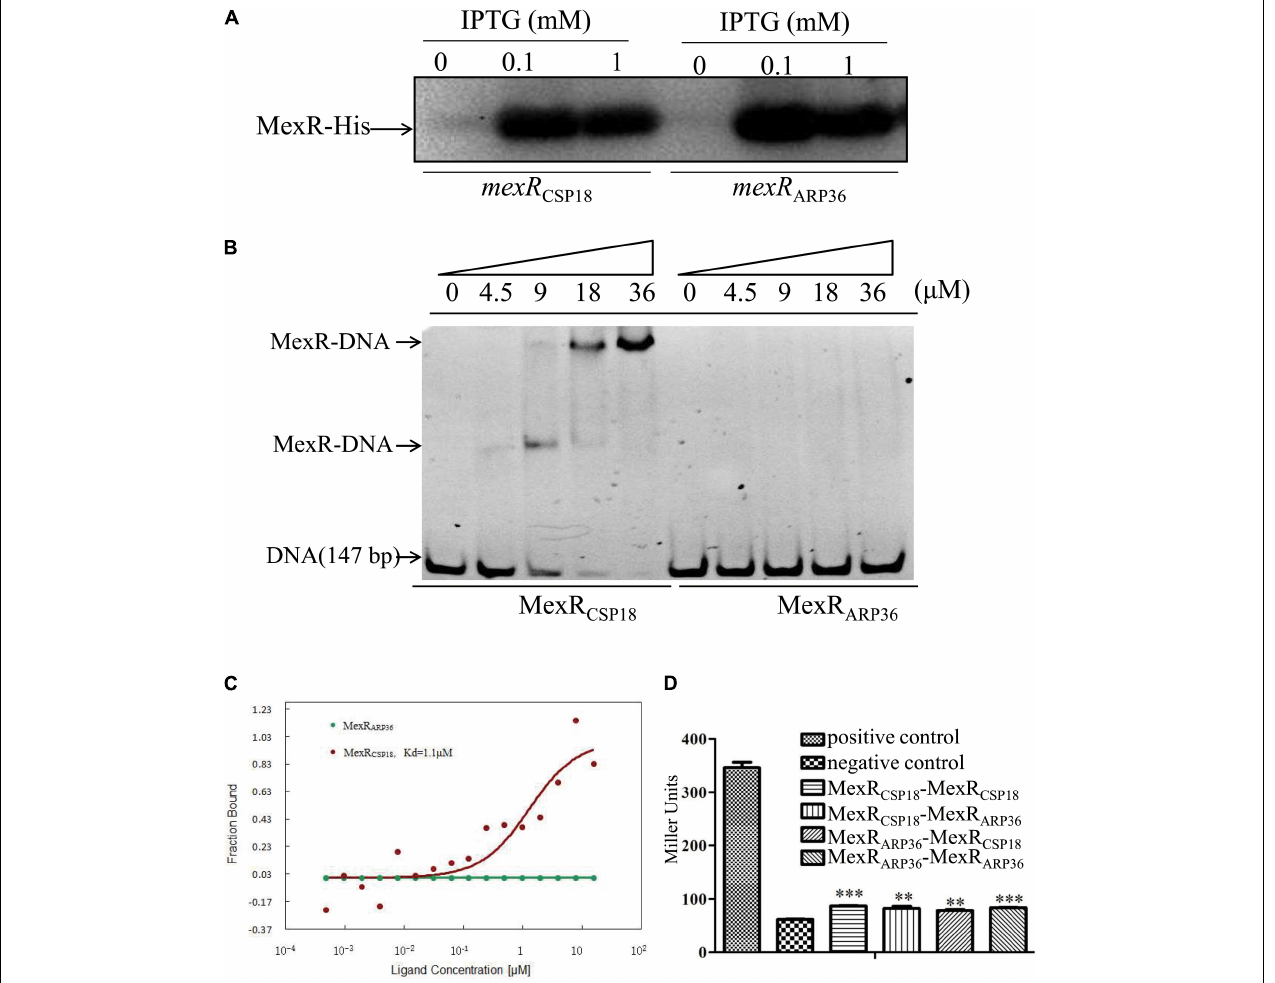
FIGURE 3 | Binding of MexR CSP18 or MexR ARP36 to the intergenic region of mexR - mexAB-oprM and interaction between MexR CSP18 and MexR ARP36 . (A) MexR-His protein detected by Western blot. (B) Binding of MexR to its target DNA was determined by EMSA. Increasing amount of the purified MexR CSP18 -His or MexR ARP36 -His protein was incubated with intergenic region of mexR - mexA . The mixtures were electrophoresed on a native PAGE gel, and the bands were visualized under UV light following ethidium bromide staining. Data represent results from three independent experiments. (C) MST assay to test the binding capability of MexR ARP36 or MexR CSP18 to the intergenic region of mexR - mexA . (D) Test of protein-protein interactions between MexR CSP18 and MexR ARP36 using the bacterial-matched two-hybrid system. ** P < 0.01; *** P < 0.001, by Student’s t -test.